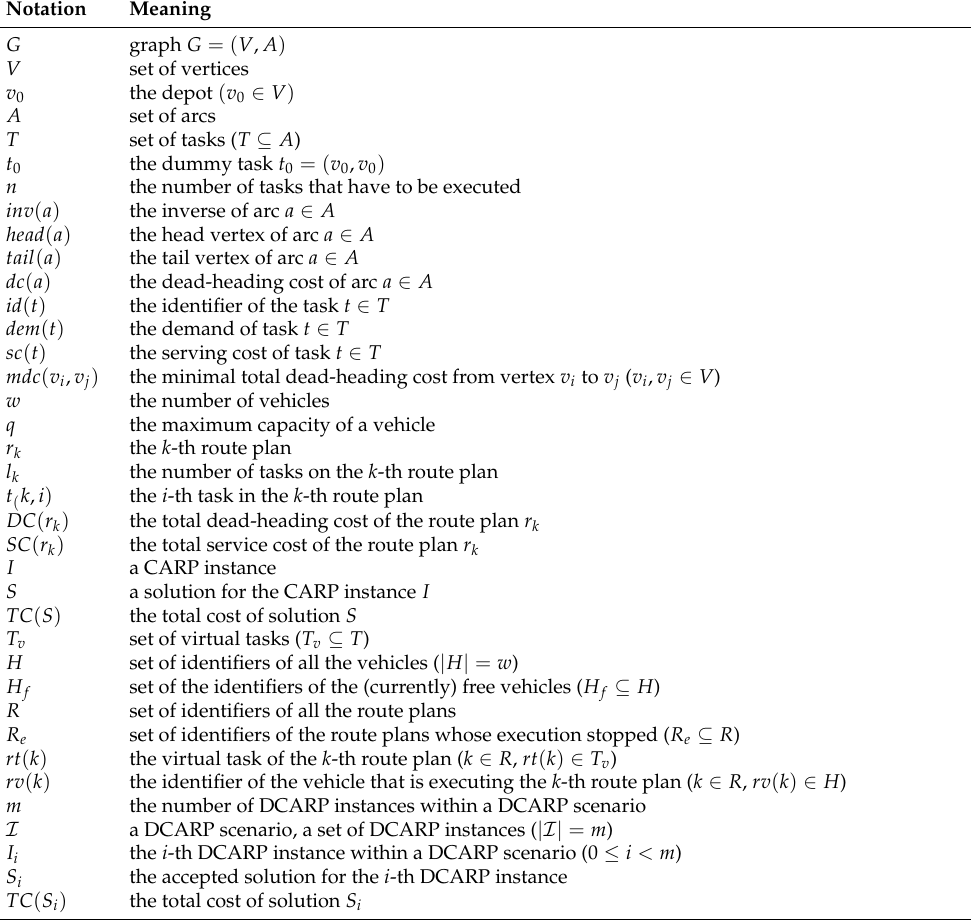
Table A1. Notations used in the CARP and the DCARP.